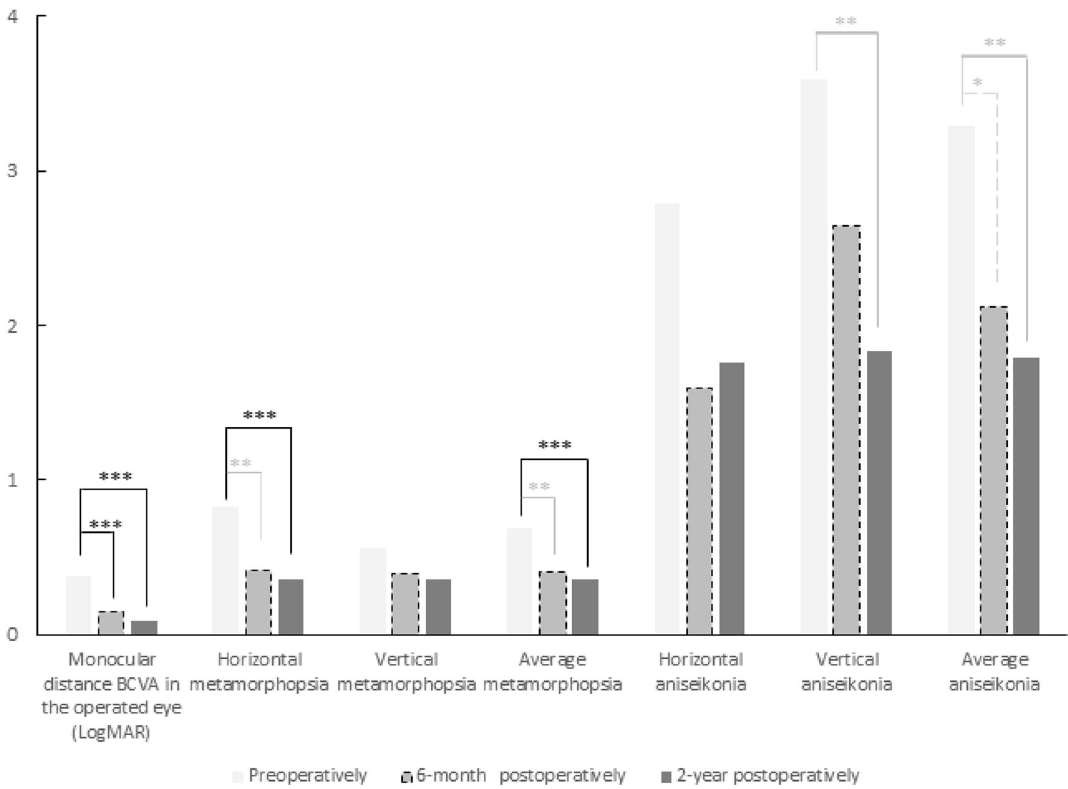
Figure 1. Evolution of the mean values of monocular distance best-corrected visual acuity (BCVA in LogMAR), metamorphopsia and aniseikonia preoperatively, 6-month postoperatively and 2-year postoperatively. The vertical axis indicates BCVA in LogMAR and values of metamorphopsia and aniseikonia using the M-CHARTS and NAT respectively; * p value < 0.05; ** p value < 0.01; *** p value < 0.001.